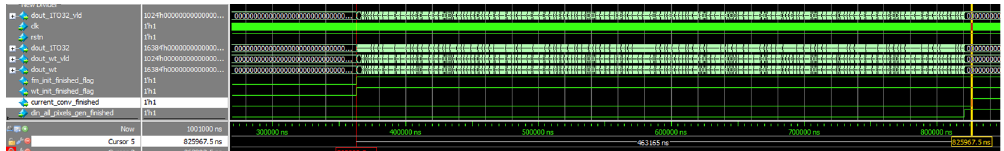
Figure 18. Simulation waveforms of 32 × 64 × 1 × 1.